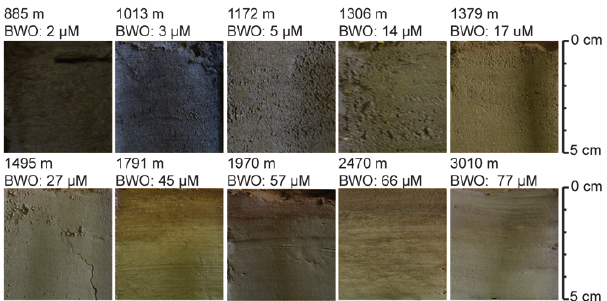
Fig. 2. Images of surface sediments from the studied oxygen tran- sect. First row: stations from 885m water depth down to 1379m depth. These are located in the OMZ where bottom-water oxygen (BWO) is less than 22µM. Second row: stations from 1495m wa- ter depth down to 3010m depth. These sites are located below the OMZ where BWO ranges from 27µM to